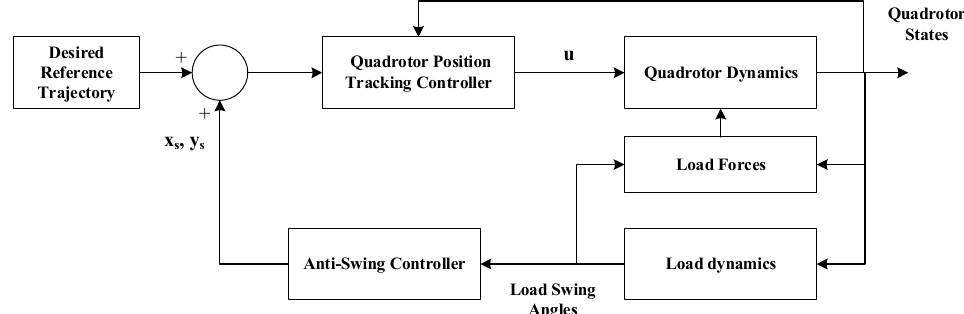
Figure 2. Proposed control loop.